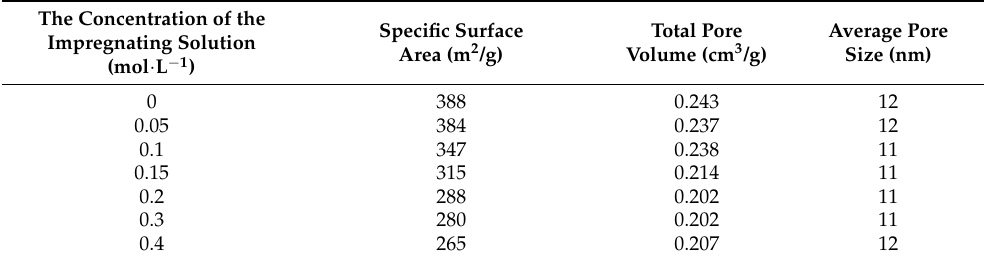
Table 4. Specific surface area, total pore volume and average pore diameter of Zn(NO 3 ) 2 modified 13X with different concentrations.